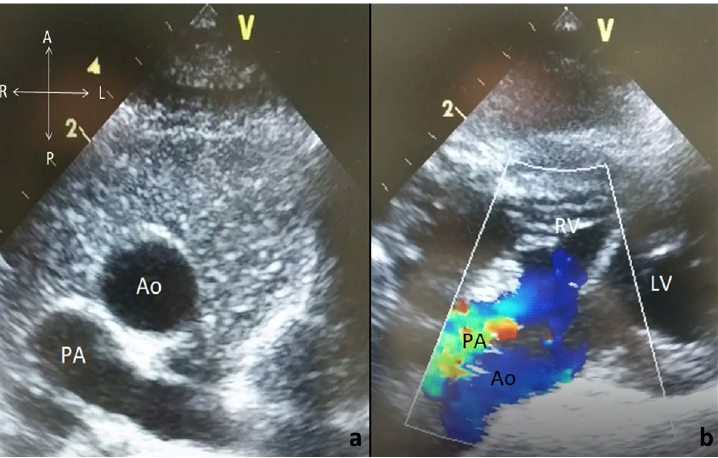
Fig. 1 - Echocardiographic two-dimensional image demonstrating the spatial relations of the great arteries in modified parasternal short axis view (a); color Doppler image showing that both great arteries are emerging from the right ventricle in modified subcostal view (b). Ao=aorta; LV=left ventricle; PA=pulmonary artery; RV=right